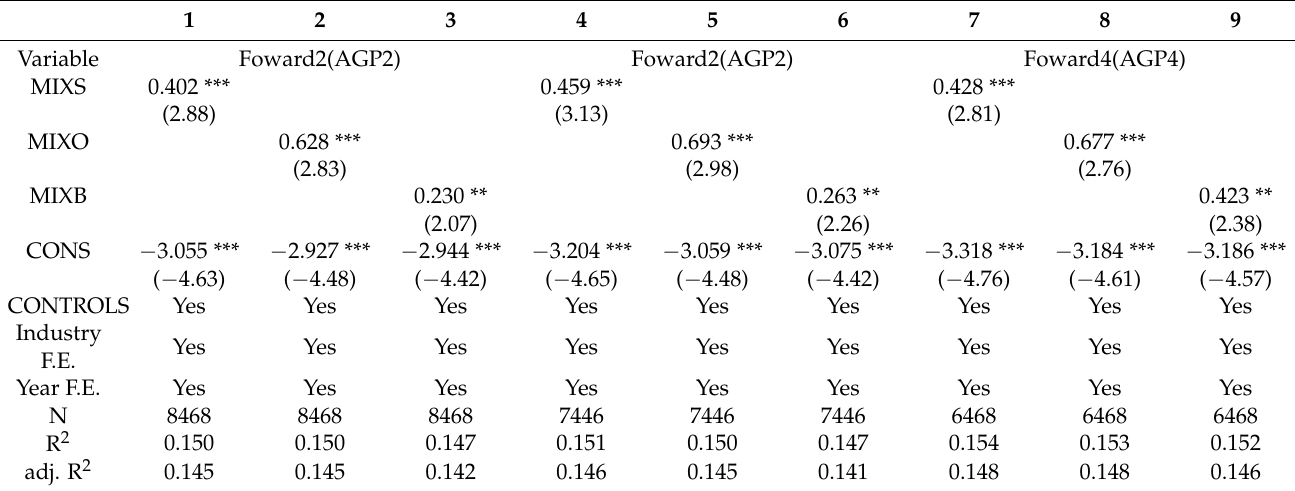
Table 6. The multiple-period lagged explained